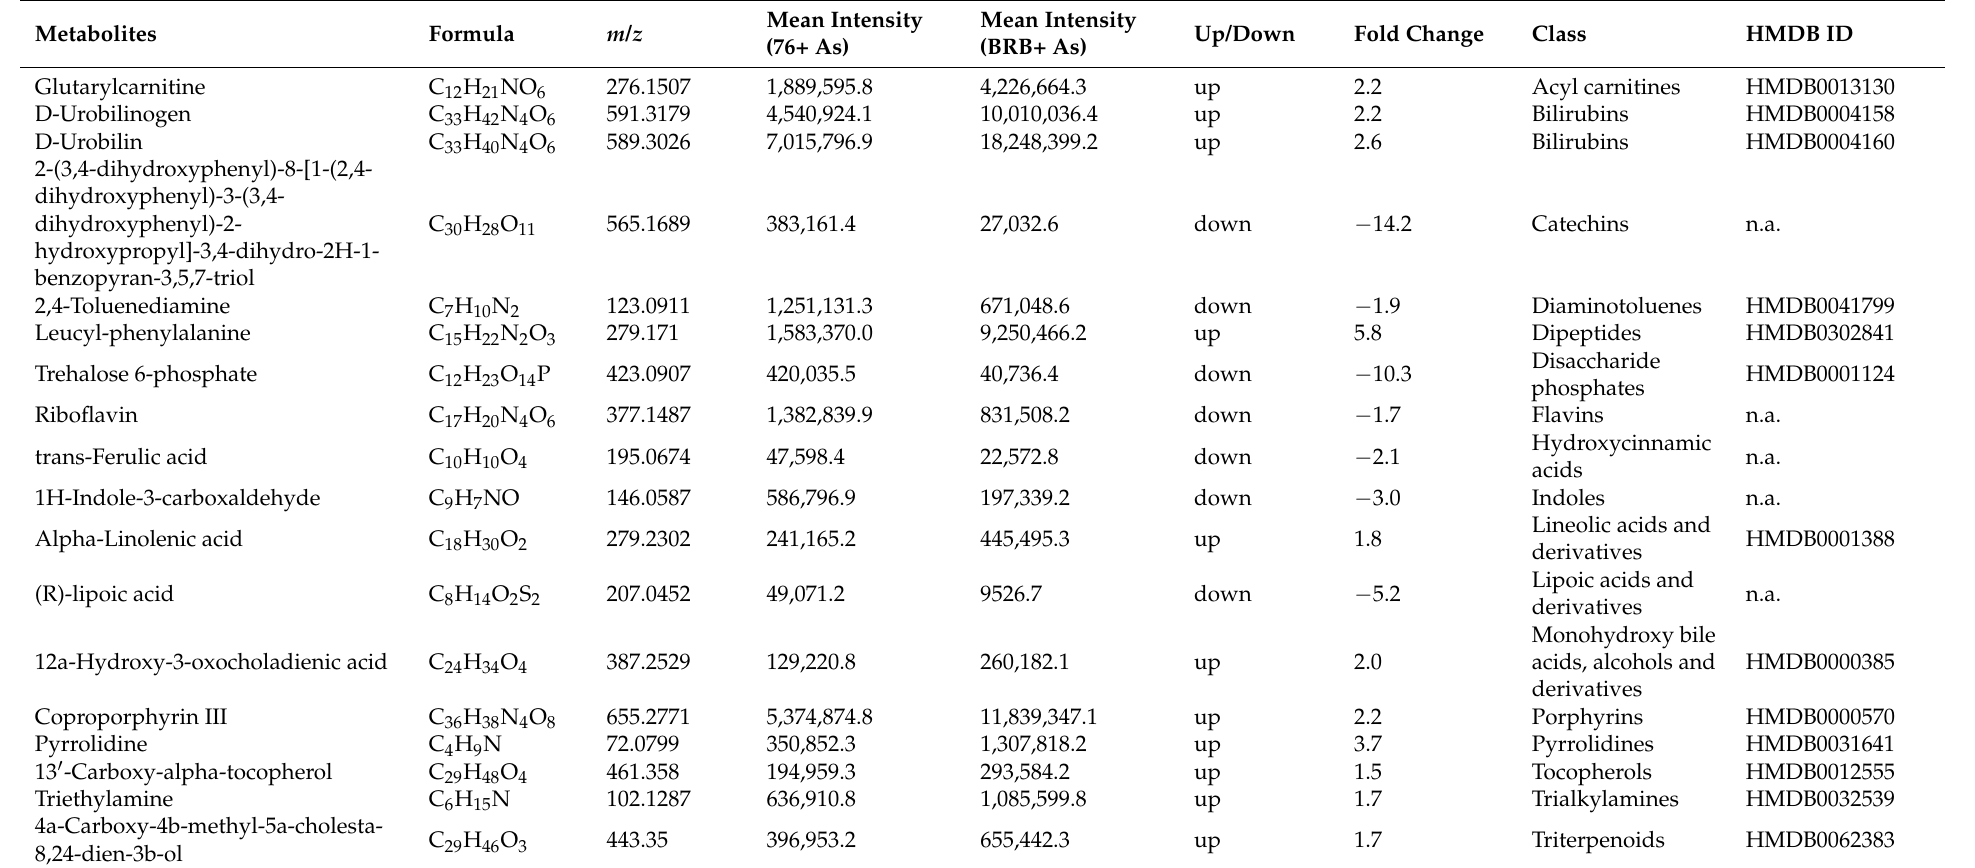
Table 2. Effects of dietary administration of BRBs on microbial metabolites of mice upon As exposure. (n.a., the HMDB ID is not available for the correspond- ing